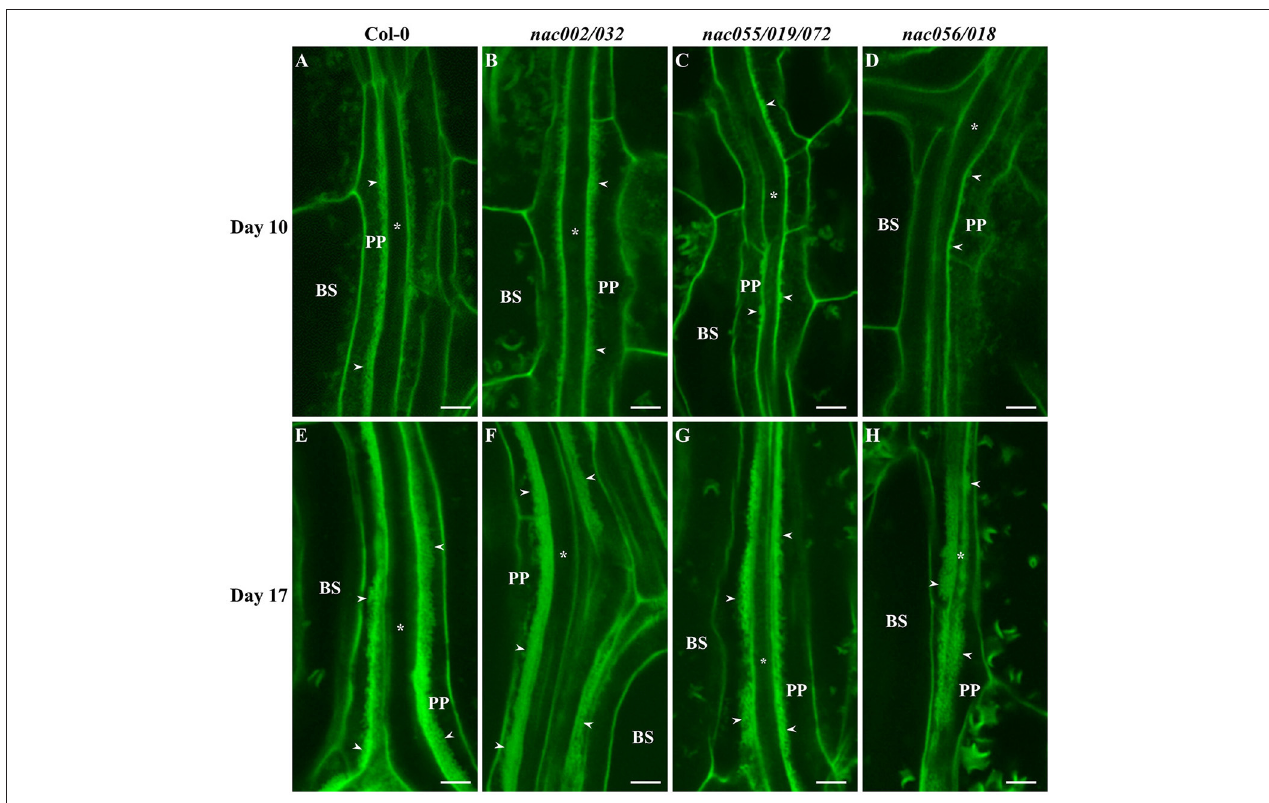
FIGURE 7 | Confocal imaging of wall ingrowth deposition in PP TCs of Arabidopsis cotyledons from Col-0 and nac mutants. By day 10, PP TCs in cotyledons from both Col-0 (A) and nac002/032 (B) showed extensive wall ingrowth deposition along the face of PP TCs adjacent to SE/CCs. In contrast, evidence of wall ingrowth deposition was detected only as discrete patches in PP TCs from cotyledons of nac055/019/072 (C) or as small projections in nac056/018 (D) . At day 17, wall ingrowths in PP TCs of cotyledons from Col-0 (E) , nac002/032 (F) , nac055/019/072 (G) and nac056/018 (H) were highly abundant (Class V; 7–8 points) and occupied a considerable volume of the PP TC. BS denotes bundle sheath cells; asterisks indicate SE/CCs; PP denotes PP cell or PP TC, as appropriate; arrowheads indicate wall ingrowths in PP TCs. The crescent-shaped fluorescent fragments occasionally seen in BS cells correspond to remnant starch grains not completely extracted by the bleach treatment. Scale bars = 5 µ